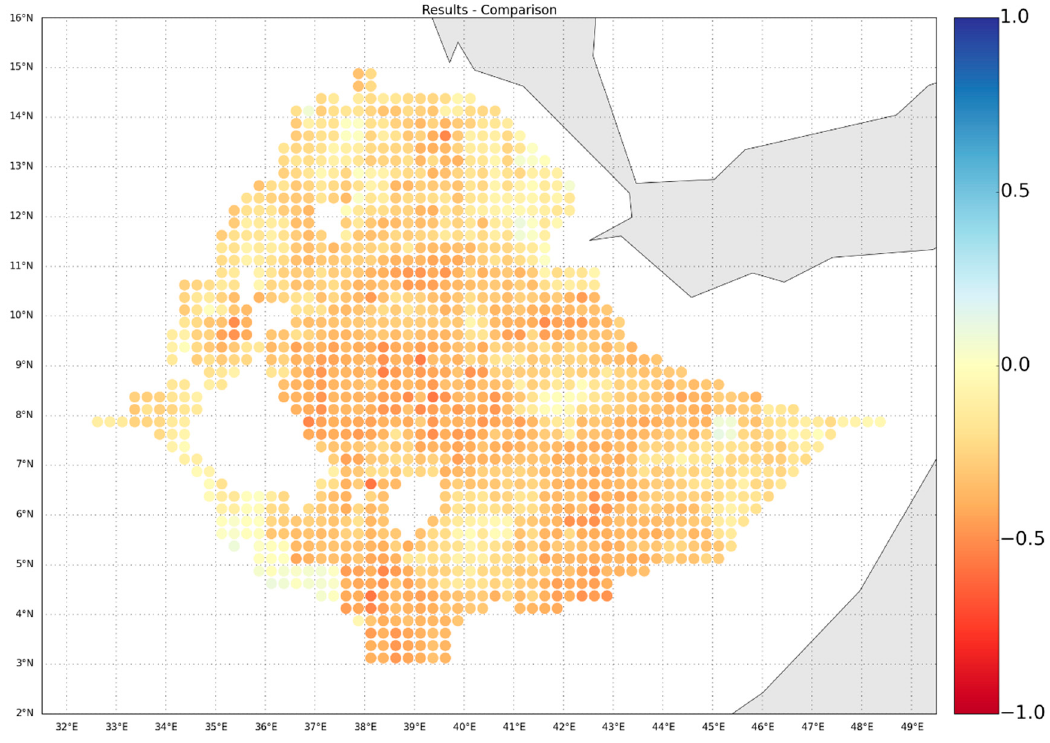
Figure 8. Comparison of ECDI warning levels and SPEI for 1992–2015: average Pearson’s R : − 0.26, and average Stdv: 0.12. Regions with dense vegetation or complex topography and lakes are masked.